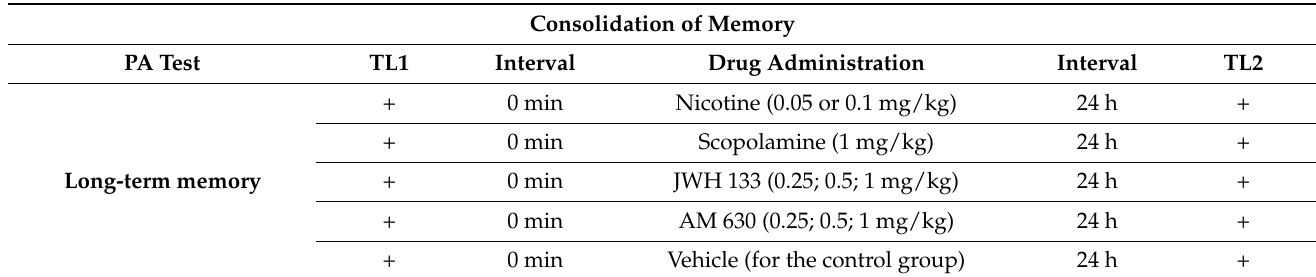
Table 2. The scheme of cholinergic and CB2-receptor ligands or vehicle administration during the assessment of long-term memory consolidation in the PA test in mice.